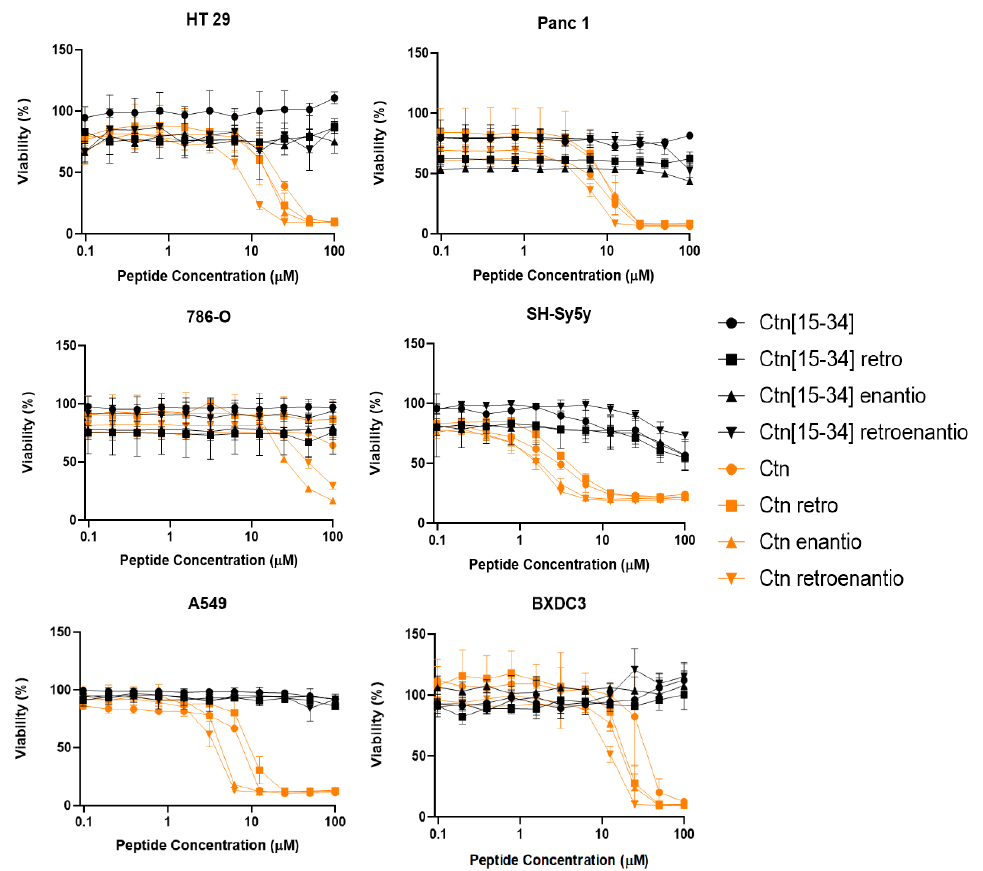
Figure 2. Viability of non-leukemia cells upon peptide treatment for 24 h. Ctn[15-34] and Ctn topoisomers are depicted in black and orange, respectively. Results are the average of three